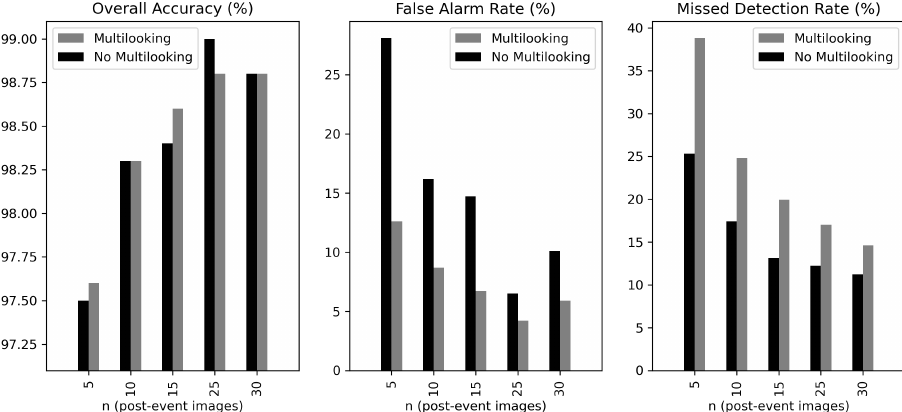
Figure 4. Area based accuracy of Sentinel-1 shadow at detecting canopy gaps in 310 ha of forest, 5.2% of which was classified as disturbed from multi-temporal UAV LiDAR data. Accuracy, false alarm rate and missed detection rate are shown as a function how many post-event images were made available to our radar change algorithm ( n ). A further distinction is made between results with or without a 3 × 3 multi-looking